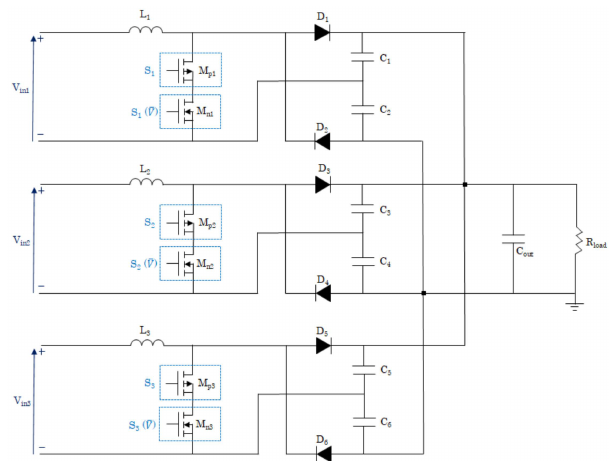
Figure 27. Split capacitor three-phase circuit with P and N MOSFETs, Split NP.